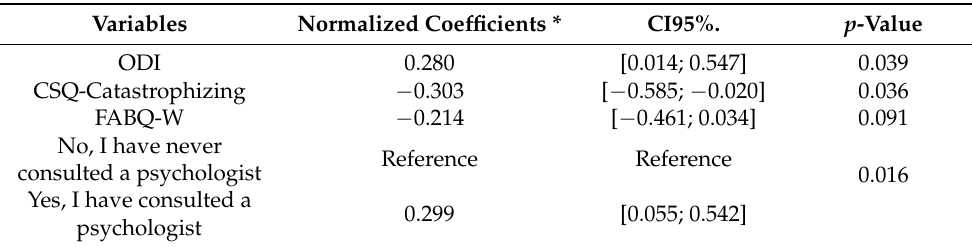
Table 5. Logistic regression describing the relationship between the Social Gradient of Health (SGH) and several dependent